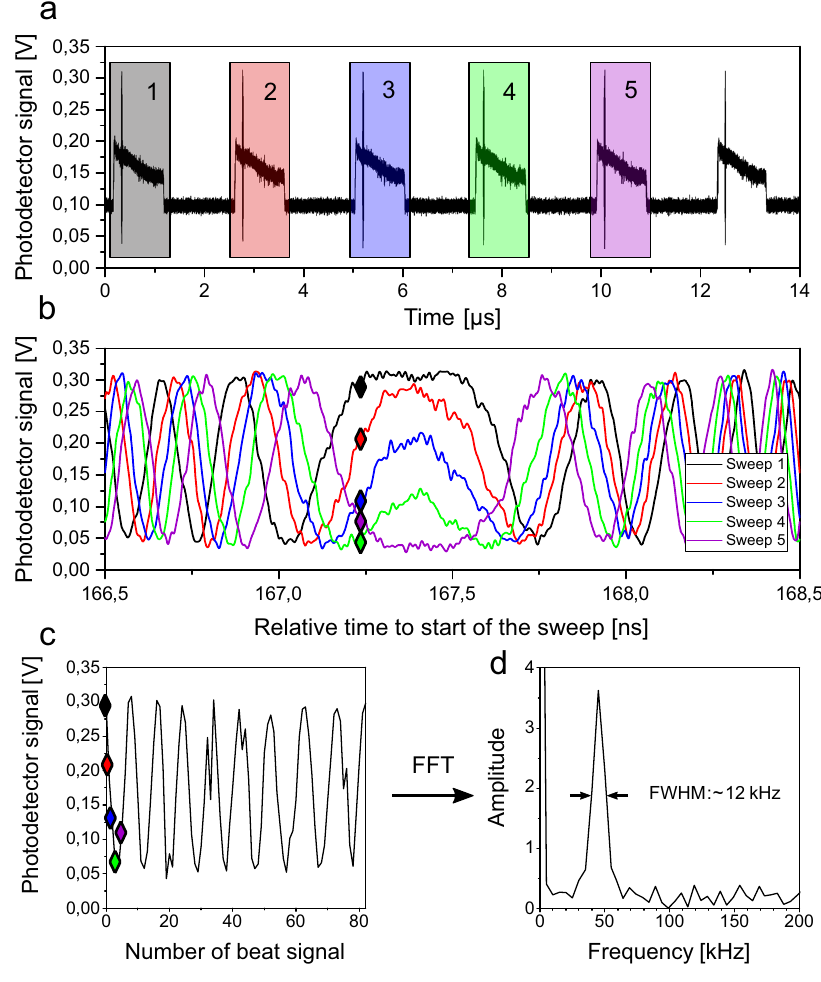
Fig. 3 Analysis of the phase evolution for a single longitudinal mode of the Fourier domain mode-locked (FDML) laser. Consecutive sweeps ( a ) were overlaid ( b ) to gain access to the phase of a single longitudinal mode and its evolution from sweep to sweep. Oscillatory behaviour is observed ( c ) when plotting the phase evolution at a single time point relative to the sweep starts (here at 167,25ns). d A fast Fourier transform (FFT) reveals an oscillation frequency of 44,6kHz. This oscillatory behaviour can be explained by a phase slip between the continuous wave (CW) laser and the FDML laser since the optical frequency of the CW laser is not necessarily an integer multiple of the FDML sweep repetition rate. However, also a carrier-envelope phase slip (CEPS) of the FDML laser could be present and convoluted in this observed oscillation. The smooth nature of the observed phase oscillation indicates a constant phase slip that accumulates linearly over consecutive sweeps. This leads to the conclusion that the FDML laser output represents a comb-like